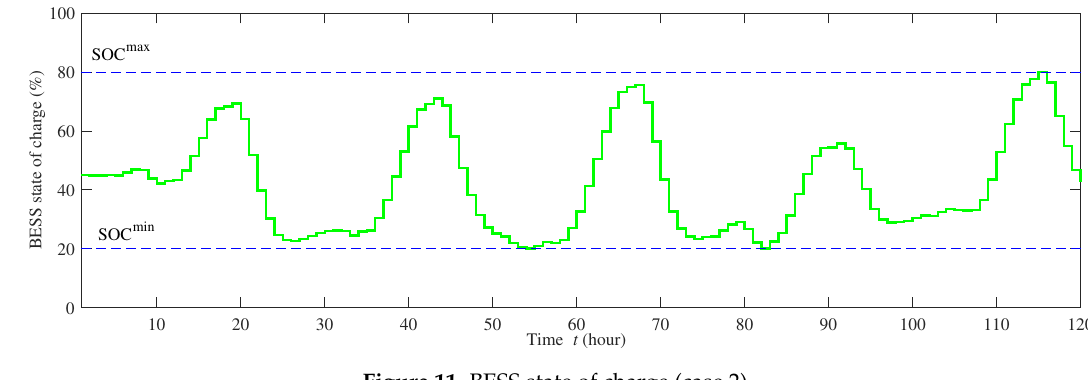
Figure 11. BESS state of charge (case